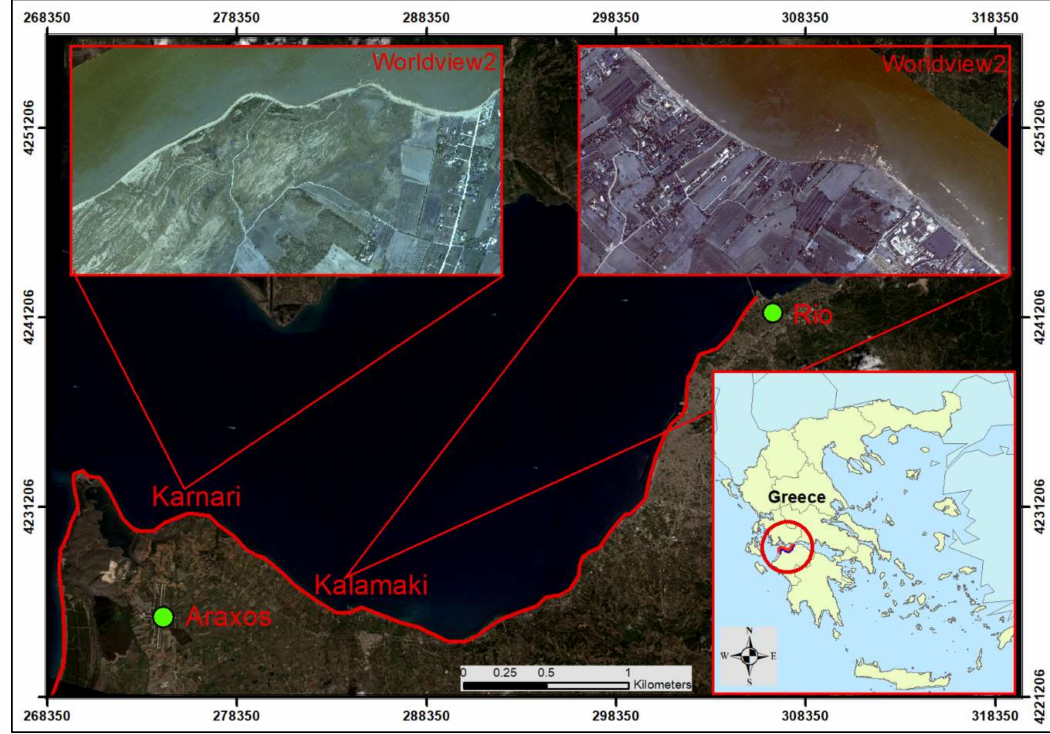
Figure 1. Map for the entire study area and both test